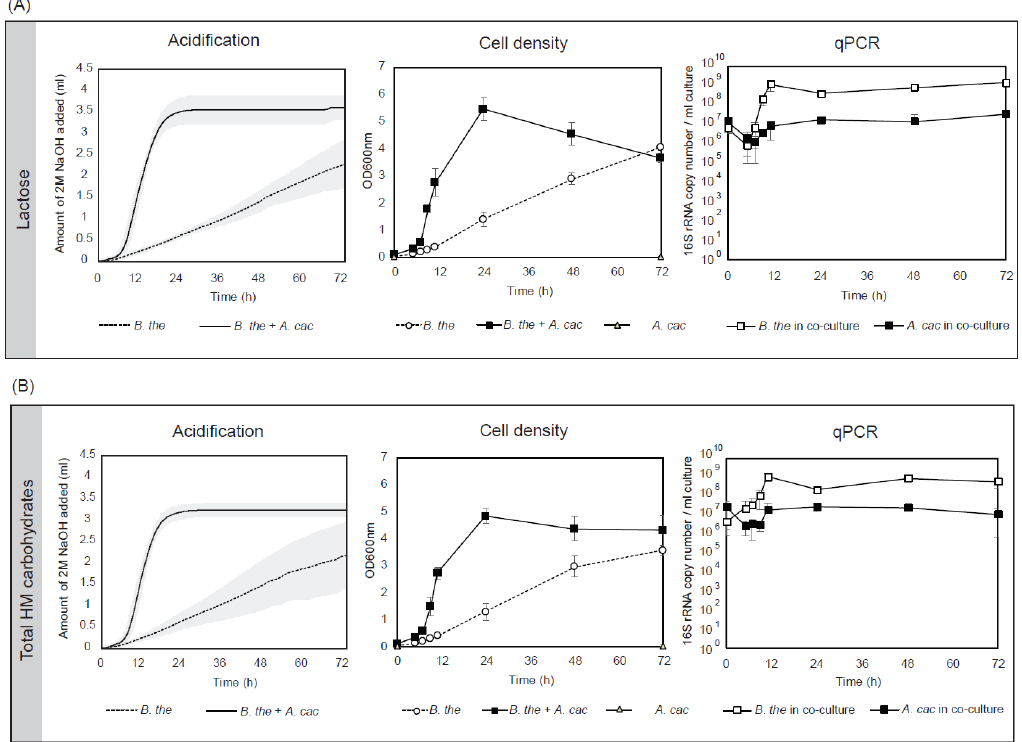
Figure 1. B. thetaiotaomicron supported the growth of A. caccae in the early-life carbohydrates. The cell density (OD600 nm), acidification, and microbial composition (qPCR) of B. thetaiotaomicron monocultures and co-cultures with A. caccae in ( A ) lactose and ( B ) total human milk (HM) carbohydrates. Fermentation was performed in an anaerobic bioreactor at pH 6.5. Error bars represent the standard deviation for biological triplicates. No growth was observed for A. caccae in the identical medium cultured in anaerobic tubes (Table